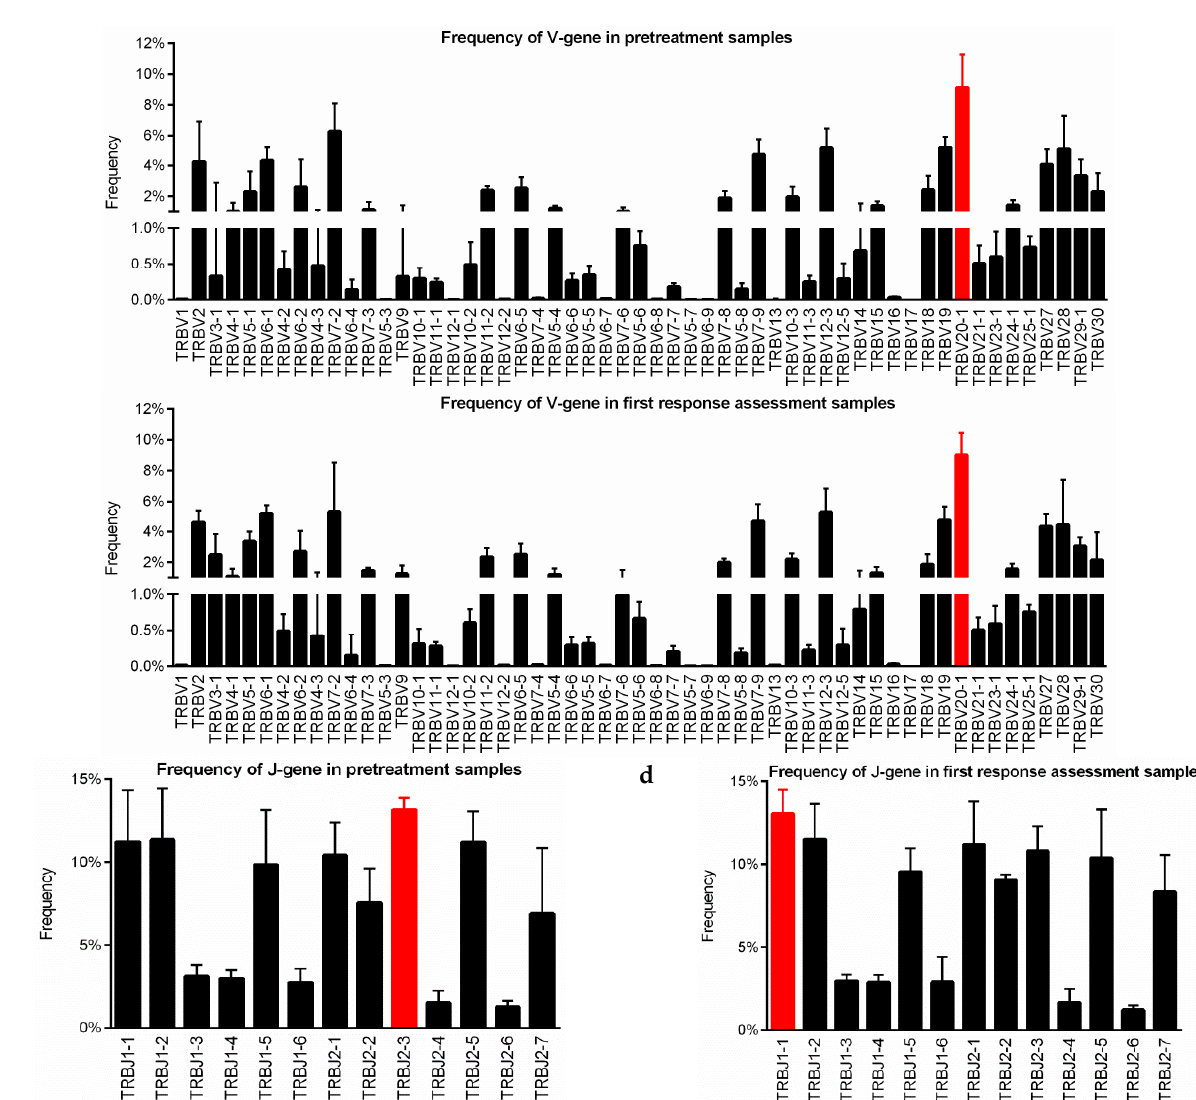
Figure 6. V and J-gene usage in anti-PD-1 treated NSCLC patients. ( a , b ) Frequency of V-gene in pretreatment and first response assessment samples. ( c , d ) Frequency of J-gene in pretreatment and first response assessment samples. The height of each column represents the median of the frequency and the error bars depict the interquartile range. The red columns correspond to V and J segments with the highest frequencies for pretreatment and first response assessment samples.